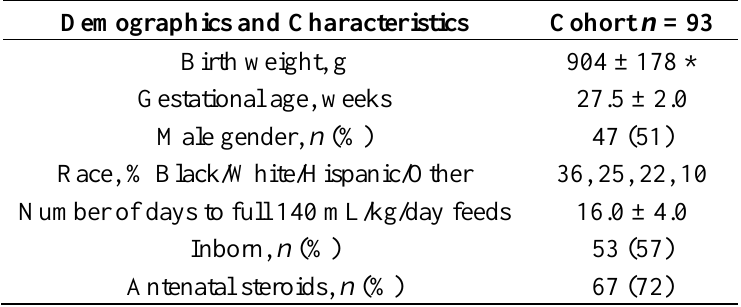
Figure 1. Infants receiving the exclusive human milk-based diet were prospectively followed. Table 1. Infant demographics and